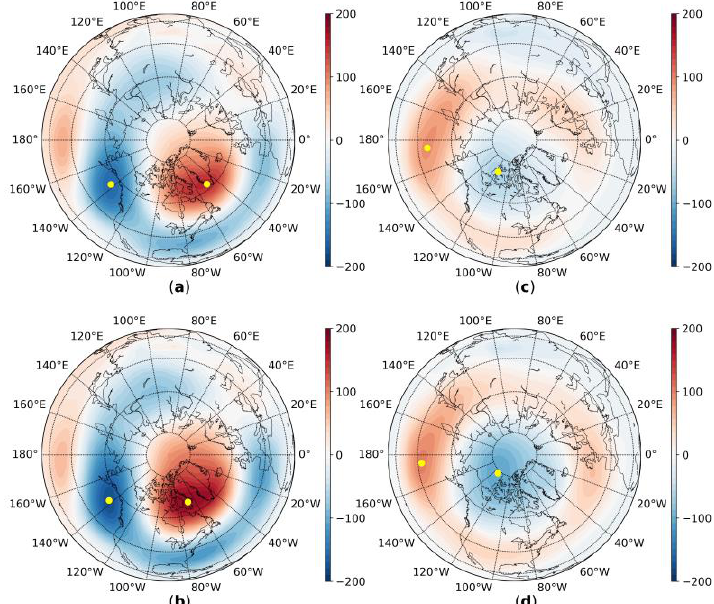
Figure 5. Differences of winter (December–February) geopotential heights for the surface 850 hPa between ( a ) EN and the CTRL experiments, ( b ) LN and the CTRL experiments, ( c ) EN&PDO+ and the CTRL experiment, and ( d ) LN&PDO − and the CTRL experiment, [m]. The position of the maximum absolute values of the hgt anomalies are marked by yellow dots.